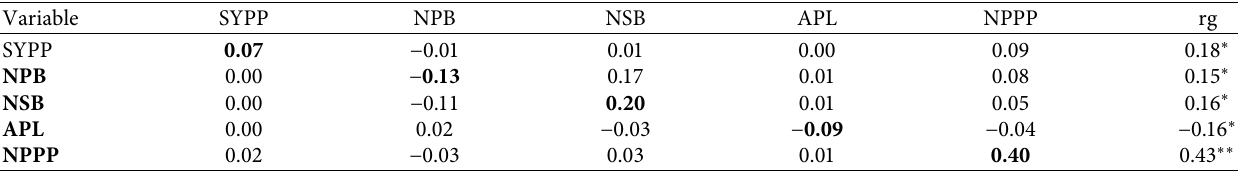
Table 5: Estimates of direct (bold-diagonal) and indirect efects (of-diagonal) of path at genotypic levels of the 10 traits on seed yield per plant in 160 fenugreek